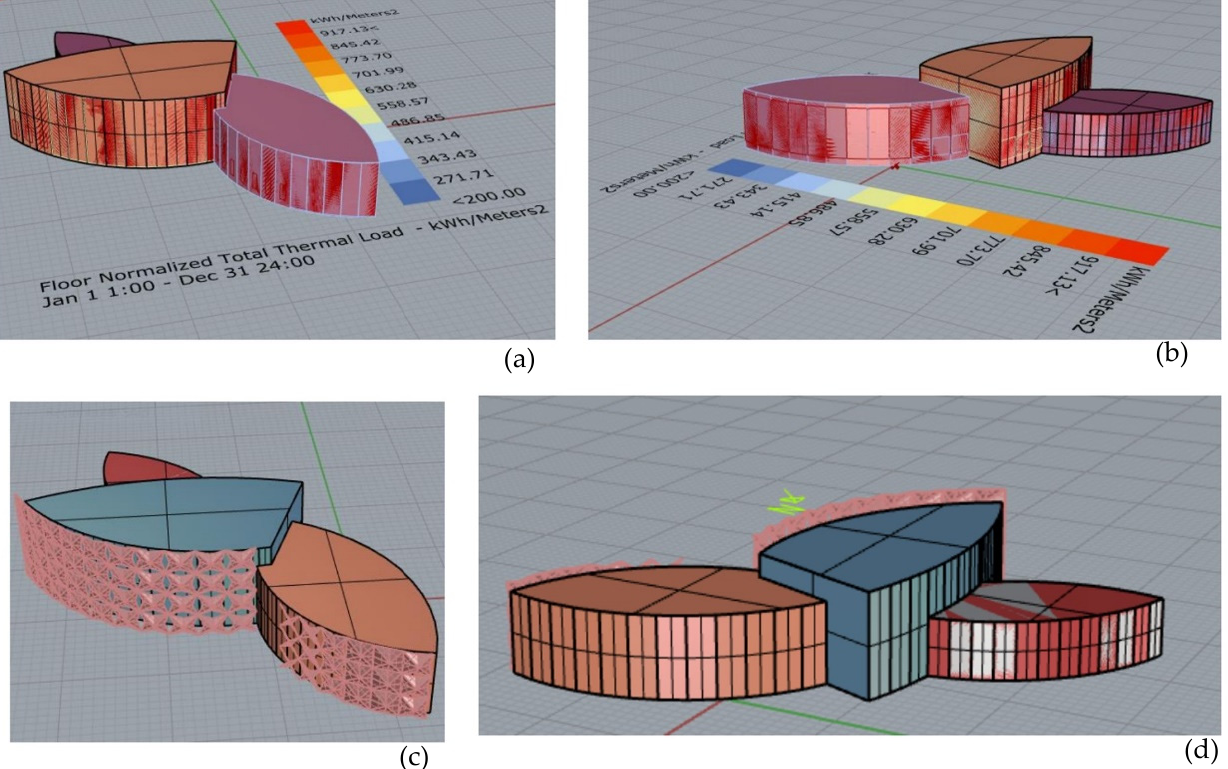
Figure 24. Energy models: ( a ) south view before parametric façade; ( b ) north-east view before parametric façade, ( c ) south view after parametric façade; ( d ) north-east view after parametric façade.